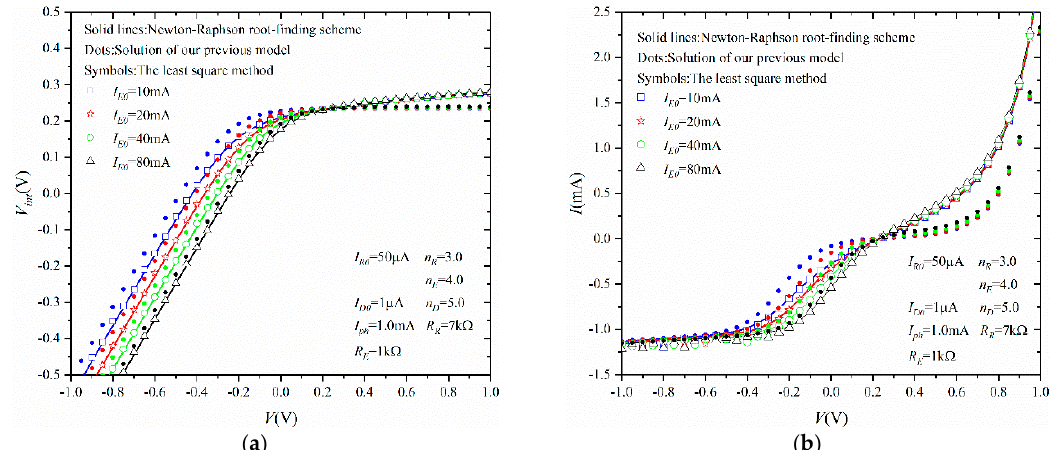
Figure 8. ( a ) V int ( V ) and ( b ) I ( V ) of the circuit in Figure 2 for different I E 0 . Catalysts 2019 , 9 , x FOR PEER REVIEW